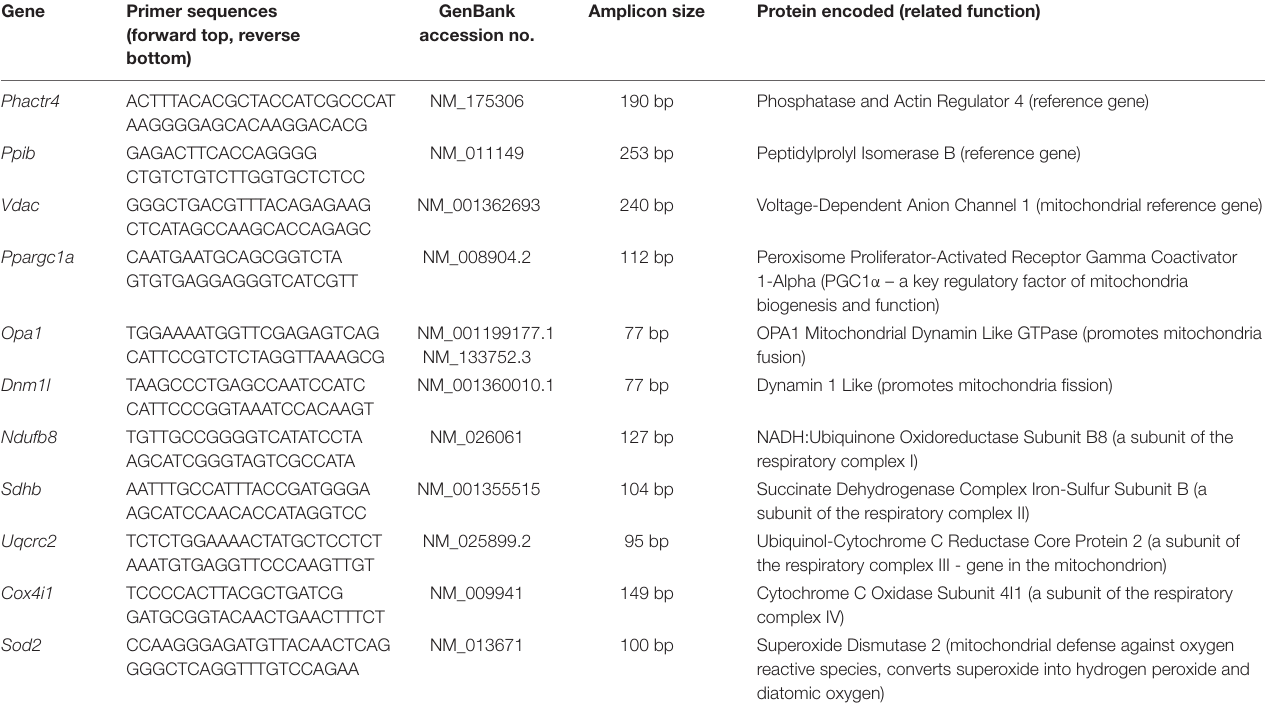
TABLE 1 | Primer list. Gene Primer sequences (forward top,